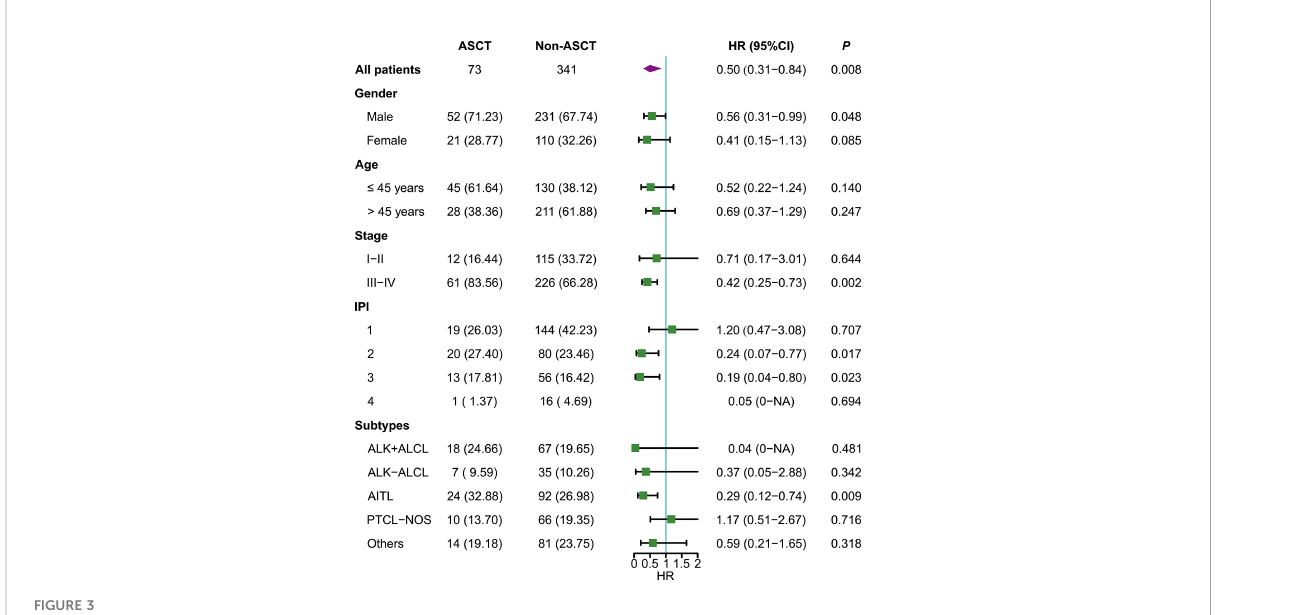
FIGURE 3 Subgroup analysis of overall